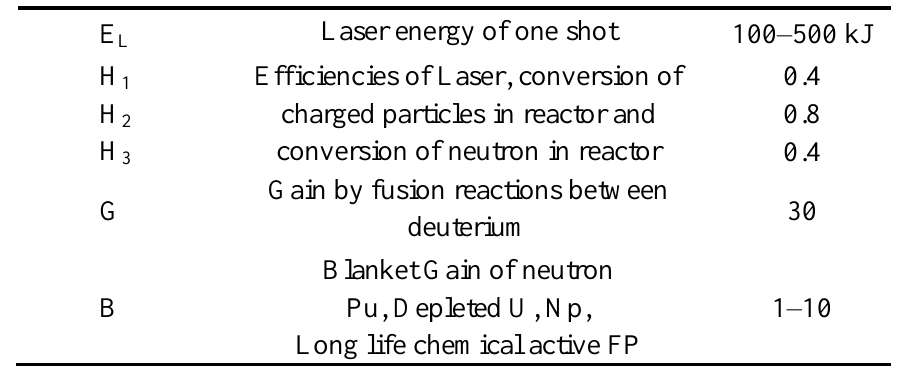
Table 1. Reactor